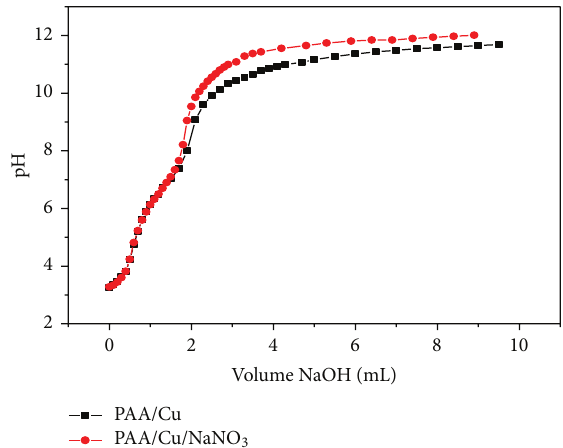
) for PAA/Cu(II). NaOH